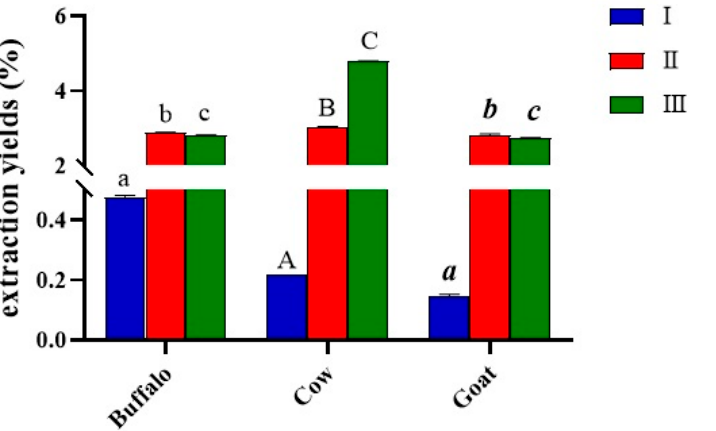
Figure 4. Extraction yields of kefiran, expressed as %, as influenced by the different extraction meth ‐ ods of using cold water (I), hot water (II), and a hybrid mild heat ‐ ultrasound (III) method. The letters on the histograms indicate the statistical analysis. Values with the same letter are not significantly different; values with different letters are significantly different ( Buffalo : I vs. II, **** p < 0.0001, I vs. III, **** p < 0.0001, II vs. III, * p < 0.05; Cow : I vs. II, **** p < 0.0001, I vs. III, **** p < 0.0001, II vs. III, **** p < 0.0001; Goat : I vs. II, **** p < 0.0001, I vs. III, **** p < 0.0001, II vs. III, ** p < 0.01).